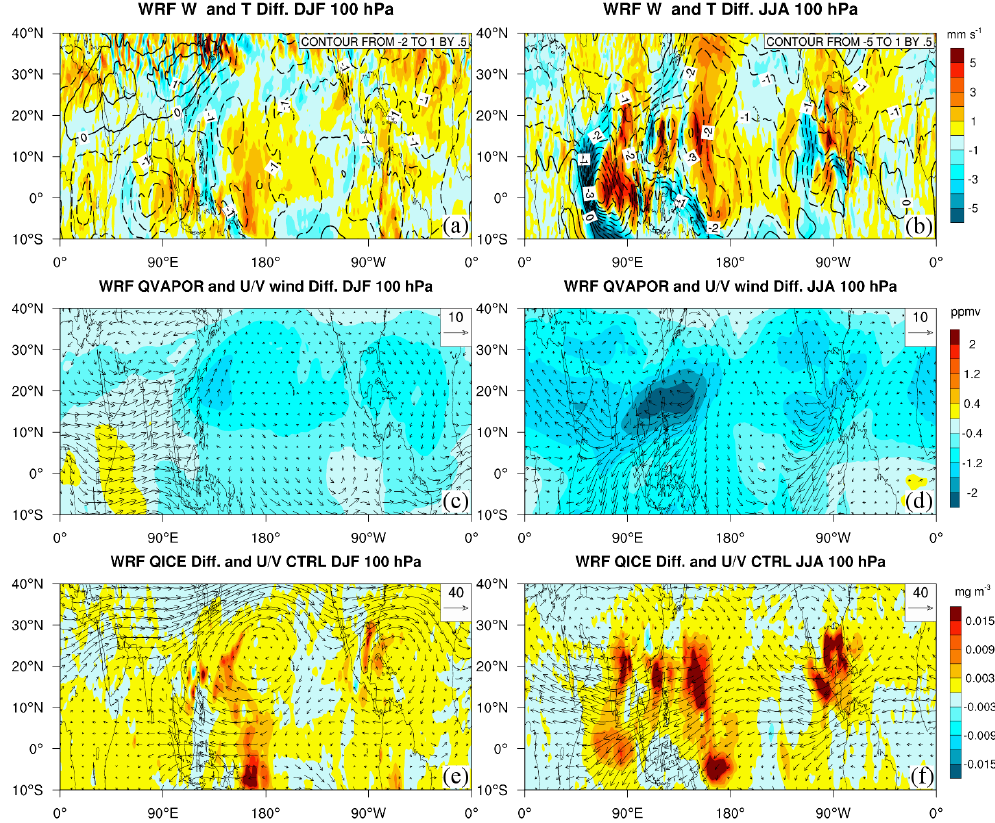
Fig. 7. (a) The differences of vertical velocity (shade; mms − 1 ) and temperature (contour with dashed lines for negative values and solid Figure 7. (a) The differences of vertical velocity (shade; mm s -1 ) and temperature (contour 2 lines for positive values; K) between the WRF CTRL and UTNR runs at 100hPa in DJF; (b) Same as (a) but in JJA; (c) The differences of with dashed lines for negative values and solid lines for positive values; K) between the WRF 3 water vapor (shade; ppmv) and horizontal wind (vector; ms − 1 ) between the WRF CTRL and UTNR runs at 100hPa in DJF; (d) Same as (c) but in JJA; (e) The horizontal wind (vector; m s − 1 ) in the WRF CTRL run and the difference of cloud ice (shade; mgm − 3 ) between the CTRL and UTNR runs at 100 hPa in DJF; (b) Same as (a) but in JJA; (c) The differences of 4 WRF CTRL and UTNR runs at 100hPa in DJF; (f) Same as (e) but in JJA. water vapor (shade; ppmv) and horizontal wind (vector; m s -1 ) between the WRF CTRL and 5 UTNR runs at 100 hPa in DJF; (d) Same as (c) but in JJA; (e) The horizontal wind (vector; m 6 215 hPa to 147 hPa. On the 4-yr average at 215 hPa, s -1 ) in the WRF CTRL run and the difference of cloud ice (shade; mg m -3 ) between the WRF 7 CTRL and UTNR runs at 100 hPa in DJF; (f) Same as (e) but in JJA. 8